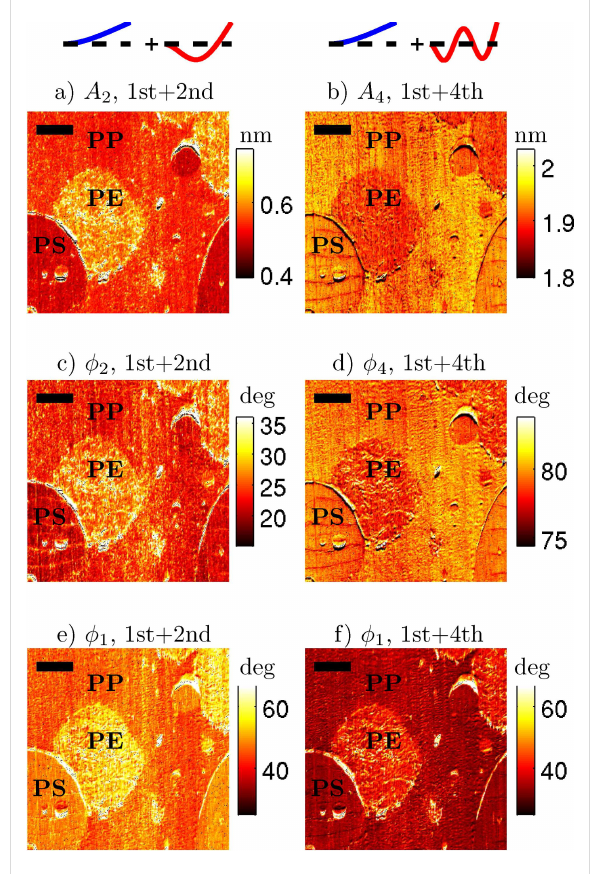
Figure 1: An 11 × 11 micrometer scan of a three component polymer blend (PS, PP, PE) imaged with an Olympus AC200 cantilever in two different modes: The left column (a,c,e) is “classical” bimodal AFM with the 1st and 2nd natural frequencies excited, and the right column (b,d,f) is bimodal AFM with the 1st and 4th natural frequencies excited. The eigenmode shapes are drawn above each column. The free ampli- tudes were the same in both cases (50 nm at the 1st eigenmode, and 2.5 nm at the 2nd or 4th eigenmode, respectively). Comparing the polyethylene (PE) to the other components, both the amplitude (a,b) and the phase lag (c,d) have a contrast between the modes. For the “1st + 2nd” image, PE has the highest A 2 and , but for the “1st + 4th” image, PE has the lowest A 4 and .